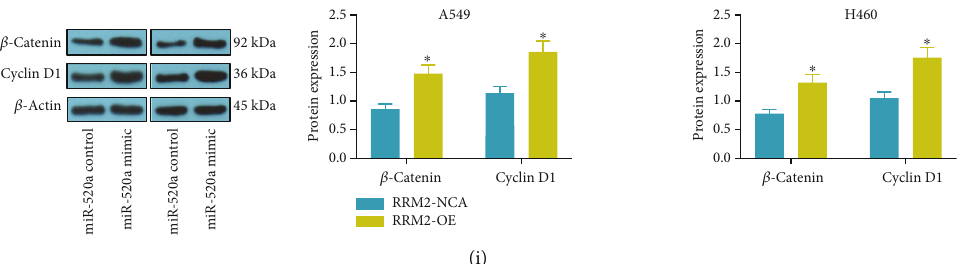
Figure 3: miR-520a directly binds to RRM2 to mediate the Wnt signaling pathway. (a) A Venn diagram for the intersected target mRNAs of miR-520a predicted on StarBase, TargetScan, miRDB, and miRbase. (b) The enriched signaling pathway by the putative mRNAs identi fi ed by GO enrichment analysis. (c) Protein levels of cyclin D1 and β -catenin in A549 and H460 cells after miR-520a mimic transfection determined by western blot analysis ( ∗ p < 0 : 05 , two-way ANOVA). (d) The expression of Wnt-enriched mRNAs in NSCLC tumor tissues determined by RT-qPCR ( ∗ p < 0 : 05 , two-way ANOVA). (e) Binding relationships between miR-520a and SDC1, YWHAZ, or RRM2 validated through dual- luciferase reporter gene assays ( ∗ p < 0 : 05 , two-way ANOVA). (f) Correlation analysis of the RRM2 and miR-520a expression in tumor tissues. (g) The RRM2 expression in NSCLC cell lines H273, H23, A549, and H460 and in normal pulmonary epithelial cell line 16HBE determined by RT-qPCR ( ∗ p < 0 : 05 , one-way ANOVA). (h) The RRM2 expression in A549 and H460 cells after miR-520a mimic transfection detected by RT-qPCR ( ∗ p < 0 : 05 , two-way ANOVA). (i) Protein levels of cyclin D1 and β -catenin in A549 and H460 cells after the RRM2 overexpression determined by western blot analysis ( ∗ p < 0 : 05 , two-way